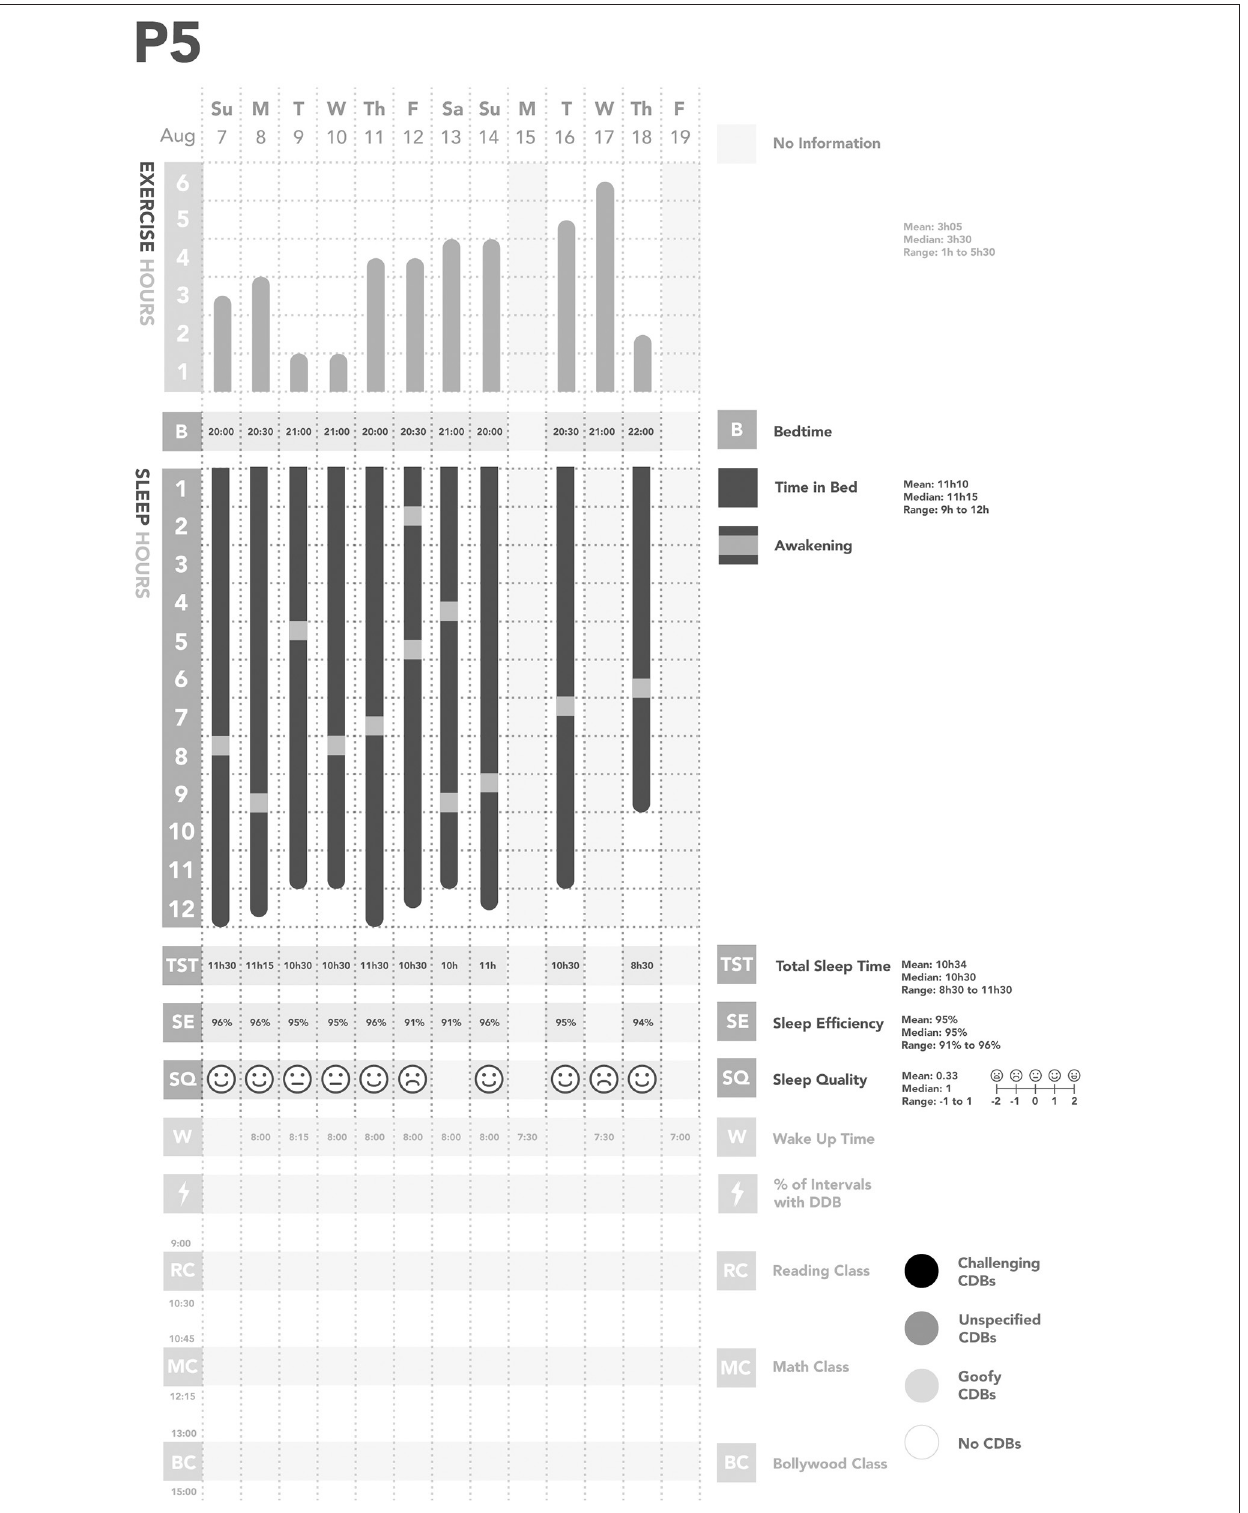
FIGURE 5 | Summary of Participant 5 (P5)’s data. CDBs, Challenging and/or disruptive behaviors.